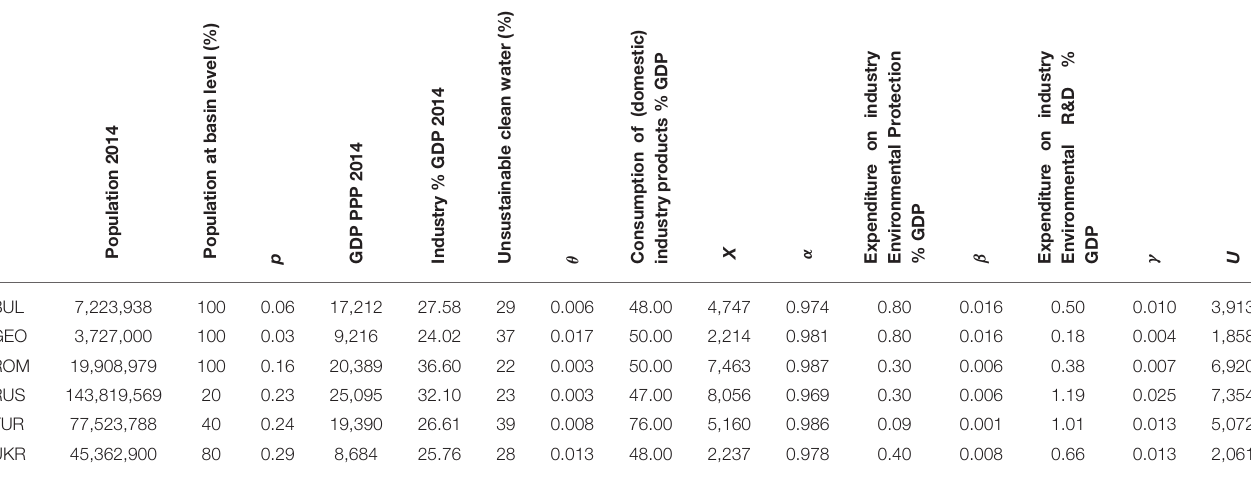
TABLE 5 | The dataset for the case study in the Black Sea.